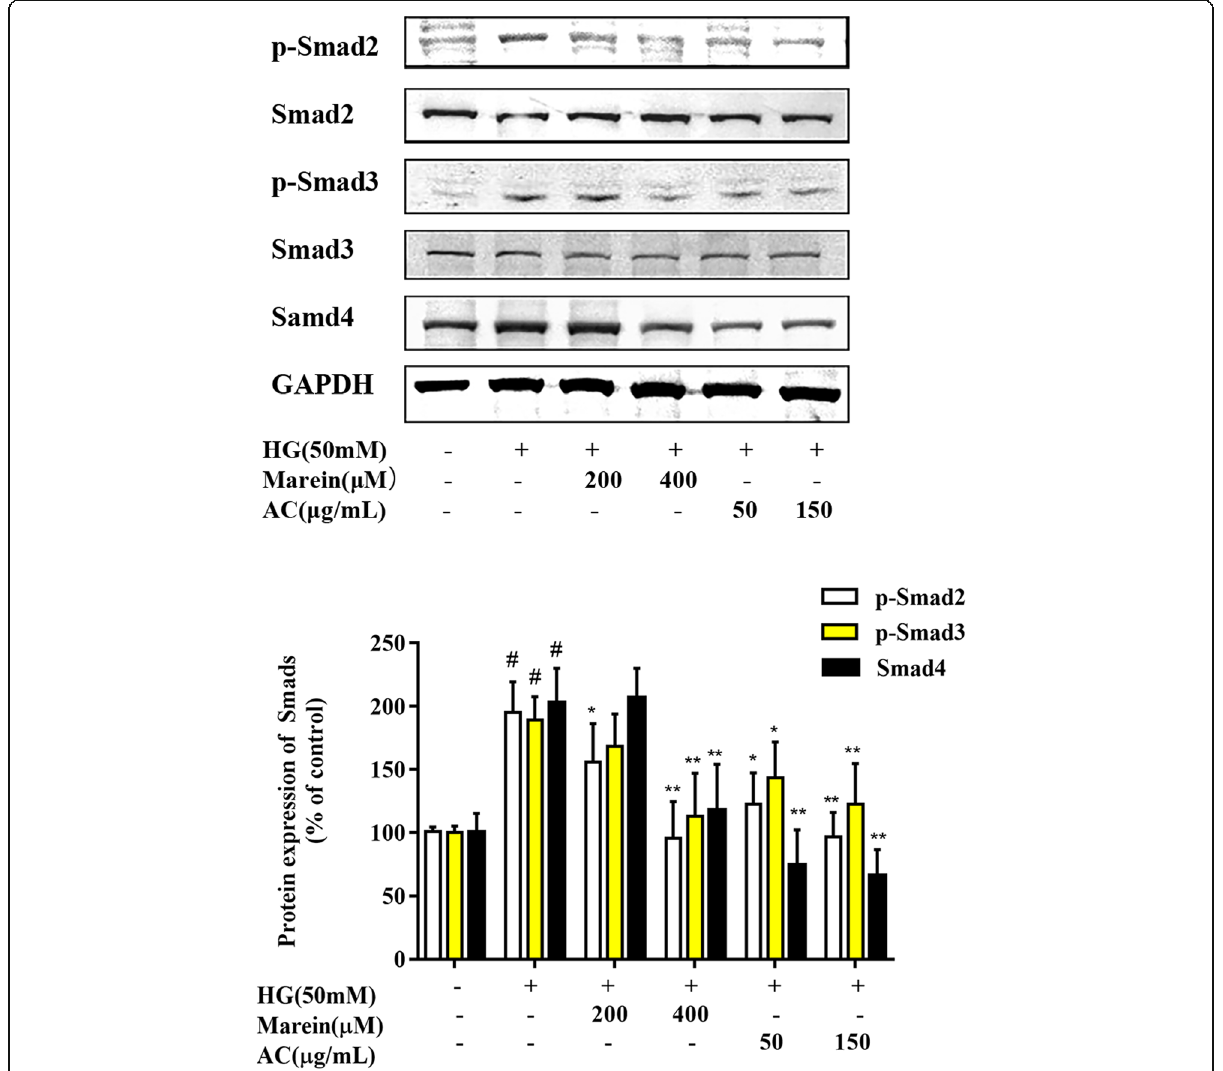
Fig. 4 Effect of AC and marein on p-Smad2, p-Smad3 and Smad4 expressions in HG-treated HBZY-1 cells by western blots. Note: Values were expressed as the mean ± SD, n = 4. # P < 0.01 versus normal group; * P < 0.05 versus control group; ** P < 0.01 versus control